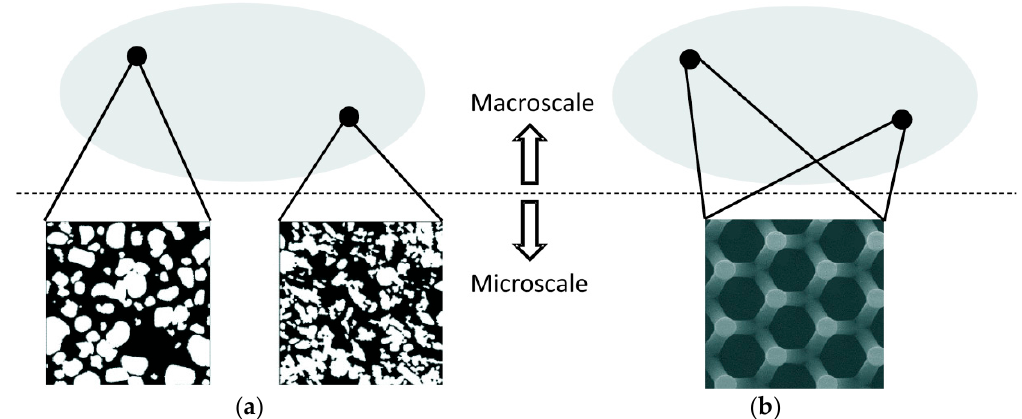
Figure 4. Concept of local ( a ) and global ( b ) periodicity. (Adapted from figures taken with permission from [38,39]).